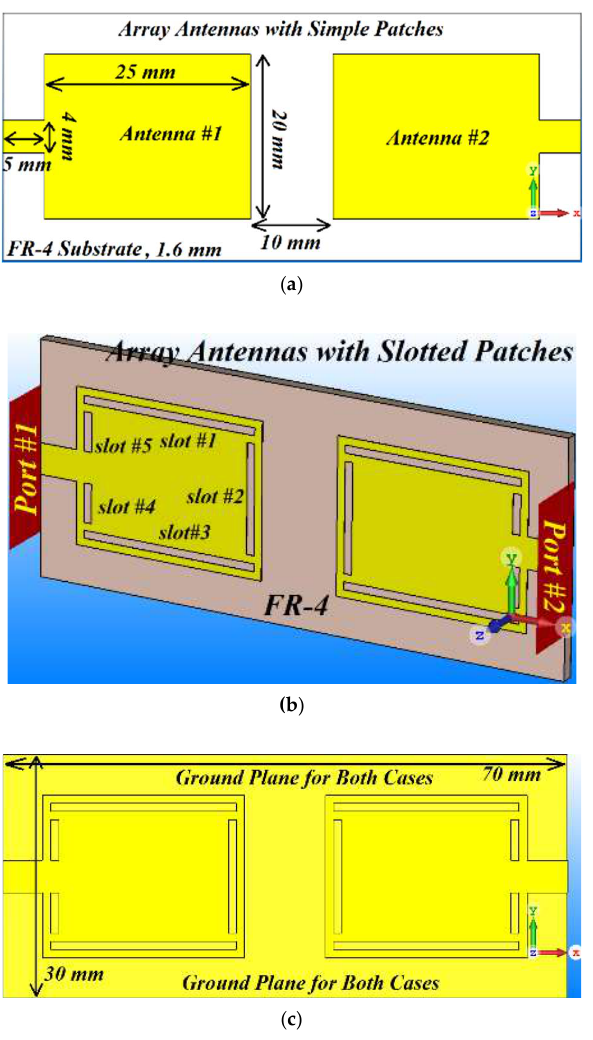
Figure 1. Array antenna prototypes (reference and proposed). ( a ) Simple reference array antenna; ( b ) Proposed slotted array antenna. Length of slots #1 to #5 are 23 mm, 14 mm, 23 mm, 5 mm, and 5 mm, respectively. Slot width is 1 mm; ( c ) Ground plane for both simple and slotted arrays.